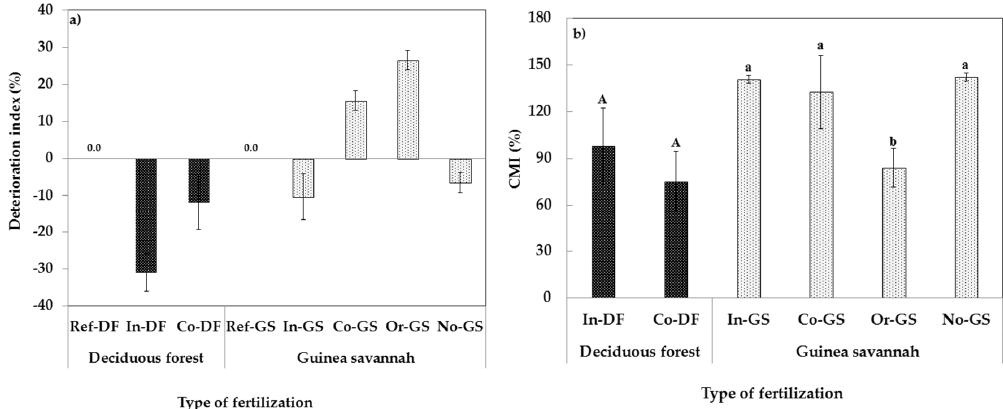
Figure 4. Deterioration index (DI) ( a ) and Carbon management index (CMI) ( b ) for different types of fertilization in the DF and GS agro ‐ ecological zones. Treatment code: Ref ‐ DF, reference DF site; In ‐ DF, inorganic fertilization at DF; Co ‐ DF, inorganic fertilizer, with low ‐ to ‐ medium organic residues at DF; Ref ‐ GS, reference site; In ‐ GS, inorganic fertilization at GS; Co ‐ GS, inorganic fertilizer, with low ‐ to ‐ medium organic residues at GS; Or ‐ GS, sole low ‐ to ‐ medium organic residues at GS and No ‐ GS, no fertilization input at GS. Each deterioration index is an average of percentage changes of TN, TC, NO 3 − -N, NH 4+ -N, Extr C, active C, PMN, MBN, MBC, and SOM relative to their respective